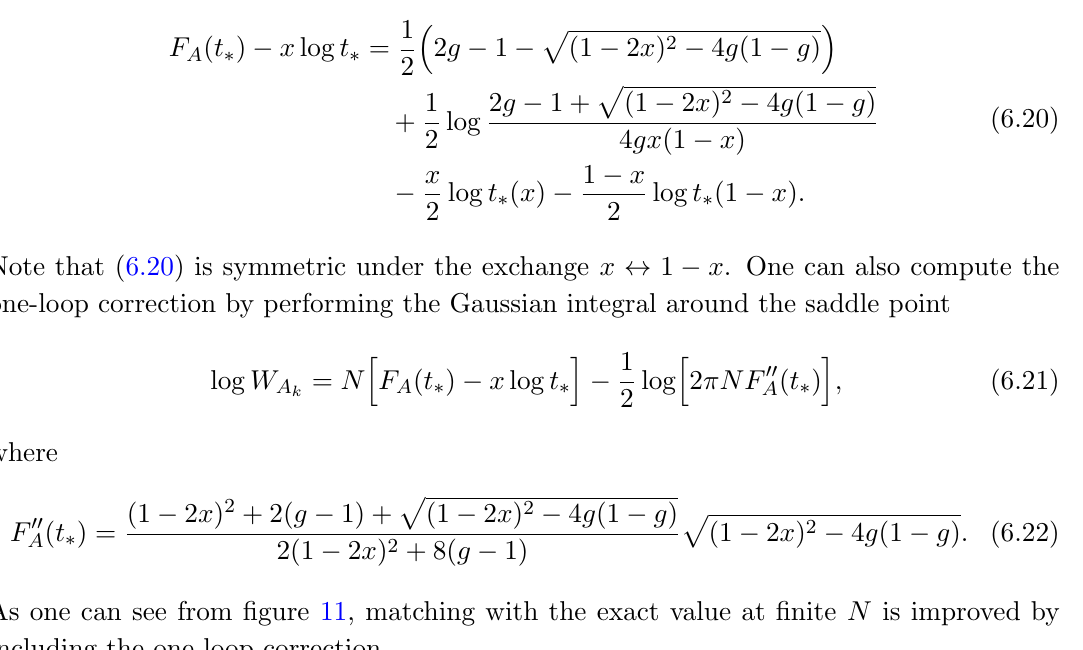
Figure 11. Plot of the log of Wilson loop in the anti-symmetric representation log W A function of k=N for g = 1 : 5 ; N = 100. The red dots are the exact values while the blue curve and the orange curve are the leading term and the leading+one-loop correction in (6.21), respectively. One can clearly see that the inclusion of the one-loop correction improves the matching with the exact